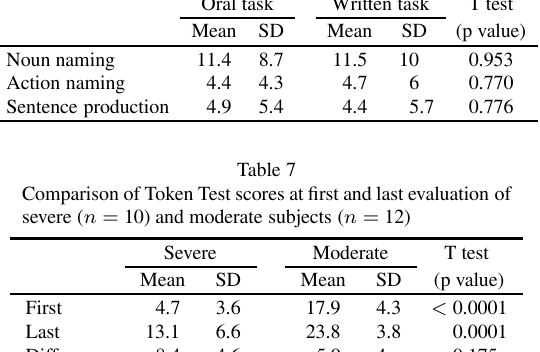
Table 6 Comparison of recovery in oral and written tasks Oral task Written task T test